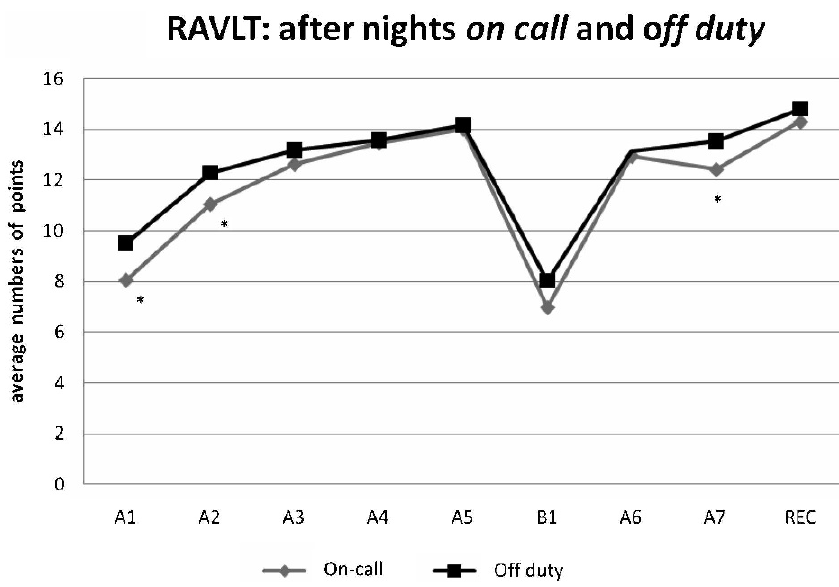
Figure 1 - Verbal learning curve (number of words recalled in each attempt) for the RAVLT. A1, A2, A3, A4, A5, A6, and A7: number of words remembered from list A; B1: number of words remembered from list B; REC: number of words from list A that were recognized. *p